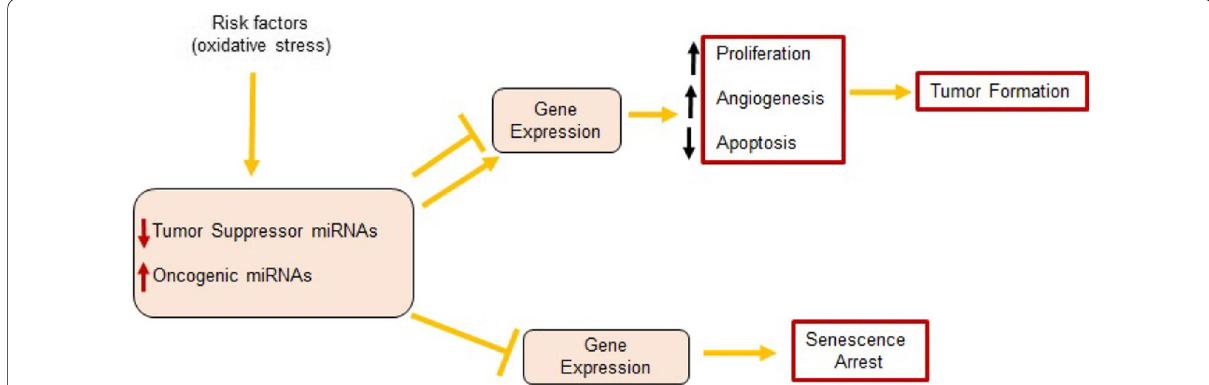
Fig. 3 Correlation of miRNA with tumor